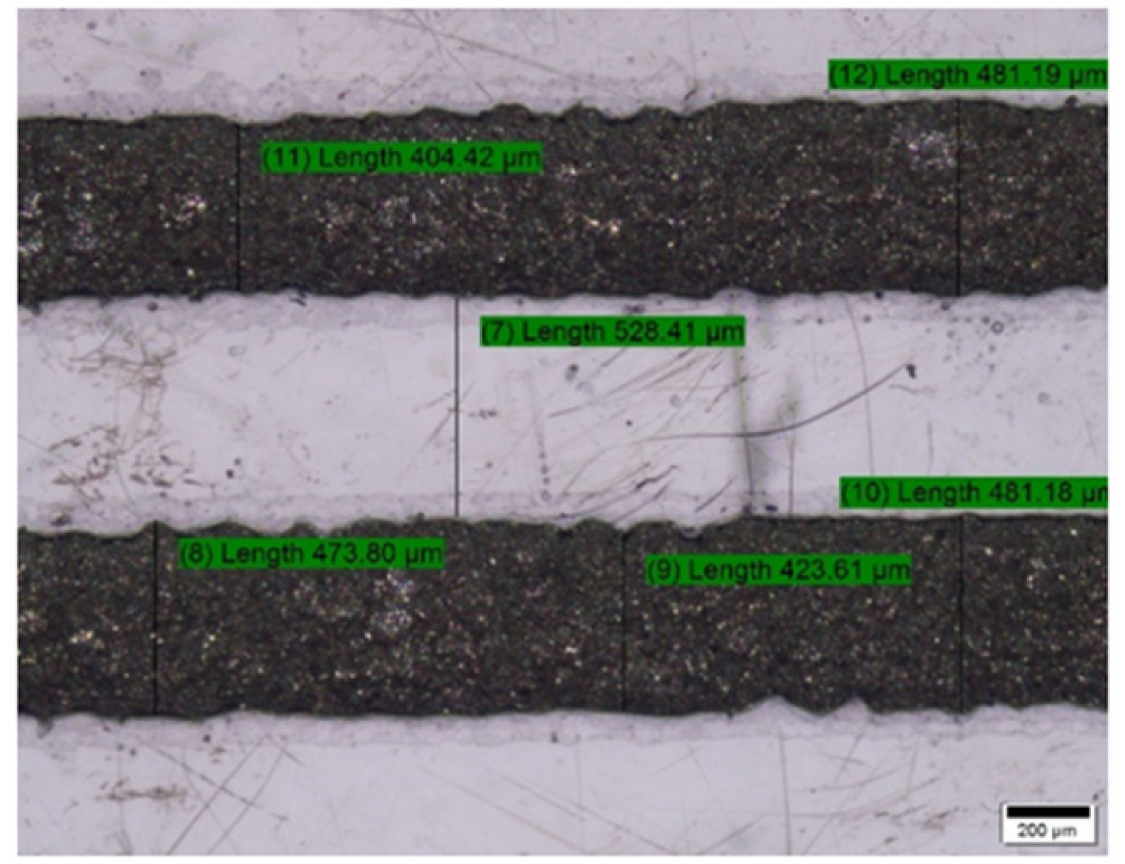
Figure 8. 0.5 mm Electrode profile of Printed sensors characterization using optical